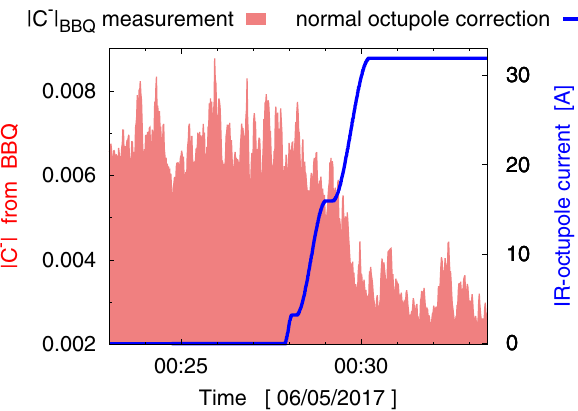
FIG. 9. Improvement in online coupling measurement upon application of normal octupole corrections in the ATLAS (IR1) and CMS (IR5)